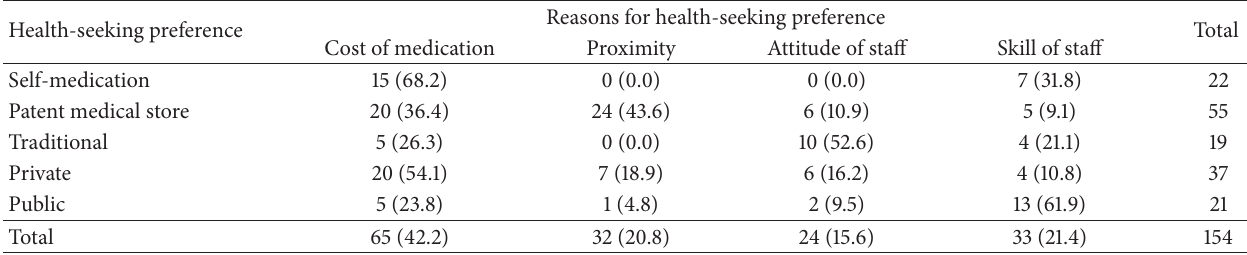
Table 4: Reasons by choice of type of health care services.